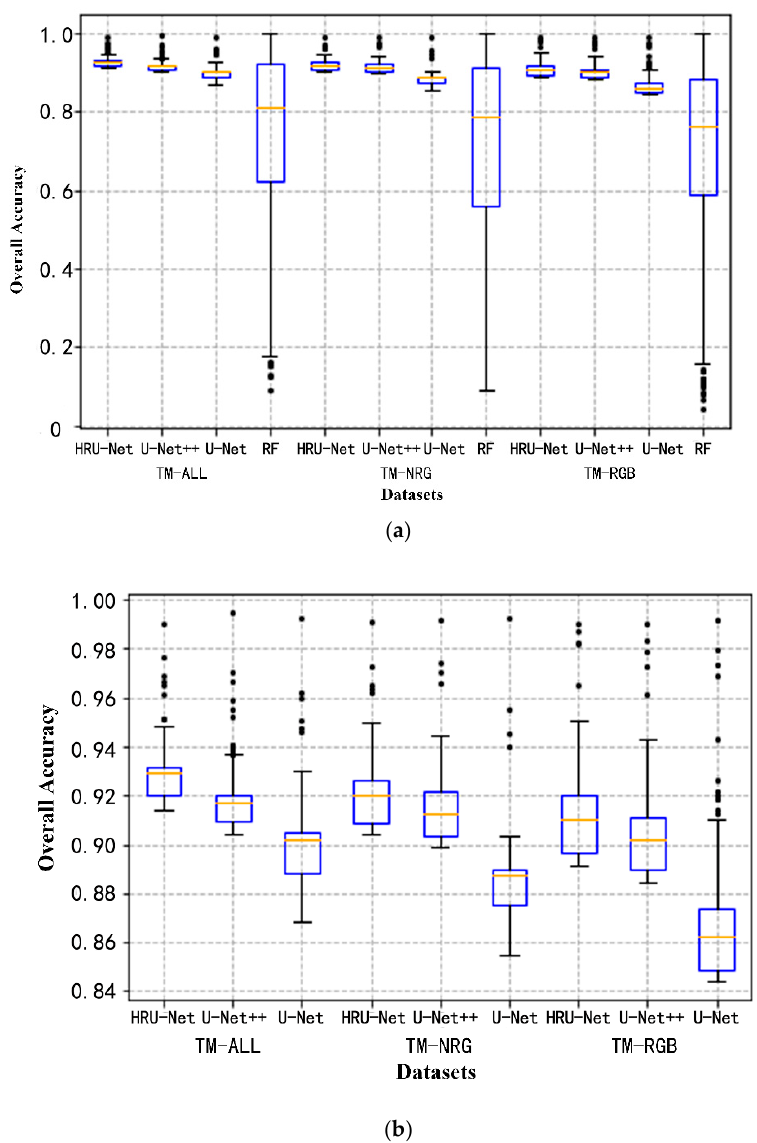
Figure 8. Boxplot of the overall accuracy distribution over the test dataset (868 tiles). ( a ) The comparison between RF and deep learning algorithms. ( b ) The comparison among HRU-Net, U-Net ++ , and U-Net.